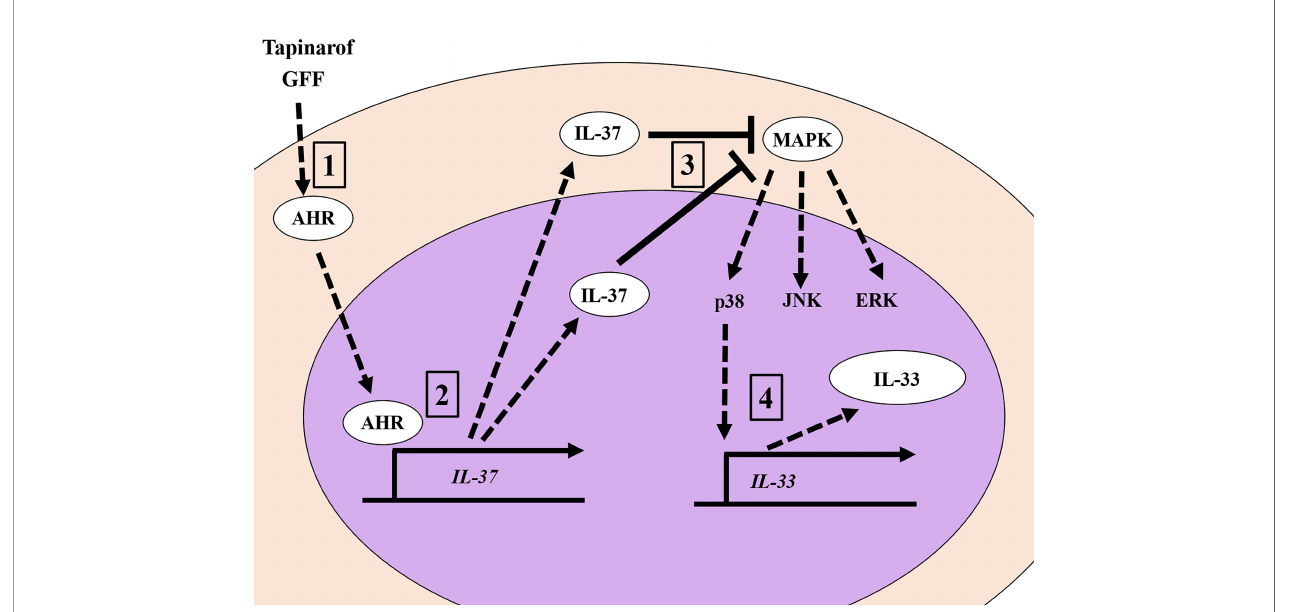
FIGURE 5 | The AHR/IL-37 axis downregulates IL-33 in NHEKs. 1. Tapinarof and GFF act on AHR. 2. Translocation of AHR upregulates IL-37 ranscriptionally. 3. IL- 37 negatively regulates the phosphorylation of p38 MAPKs. 4. Inhibition of p38 phosphorylation results in the downregulation of